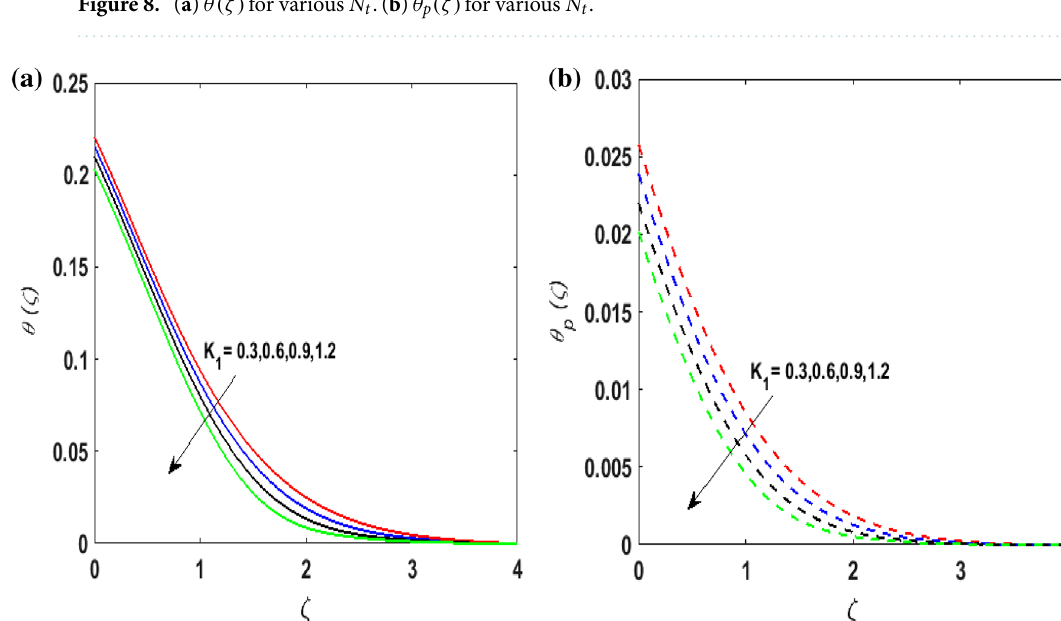
Figure 9. ( a ) θ(ζ) for various K 1 . ( b ) θ p (ζ) for various K 1